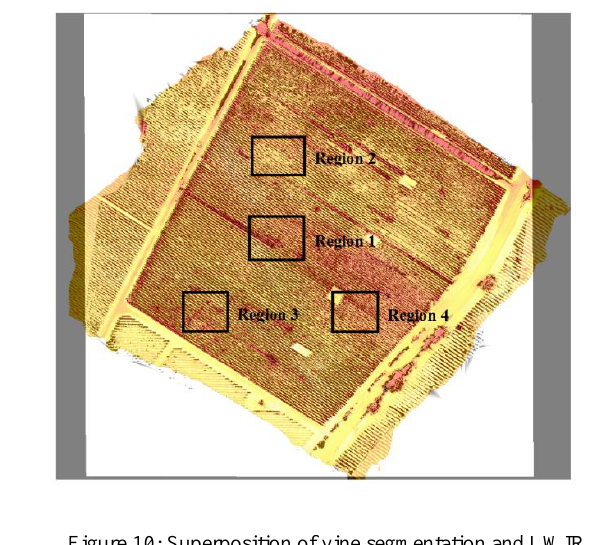
Figure 10: Superposition of vine segmentation and LWIR